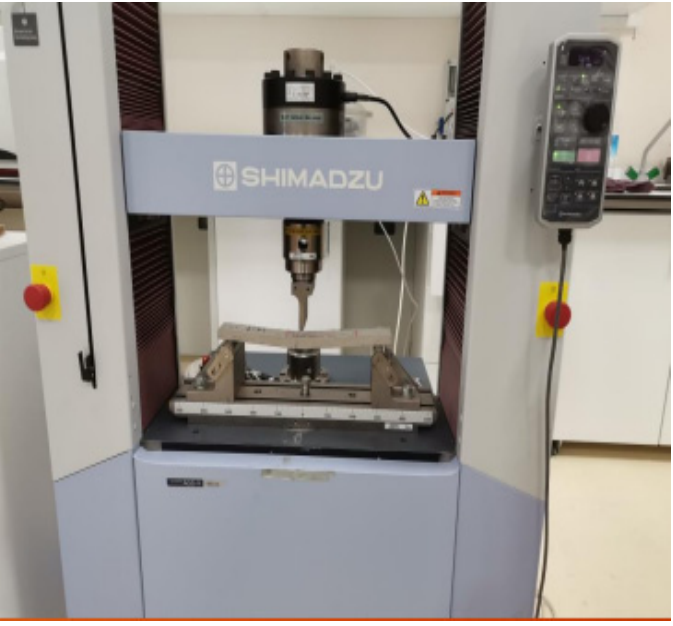
Figure 3. The flexural test set-up.